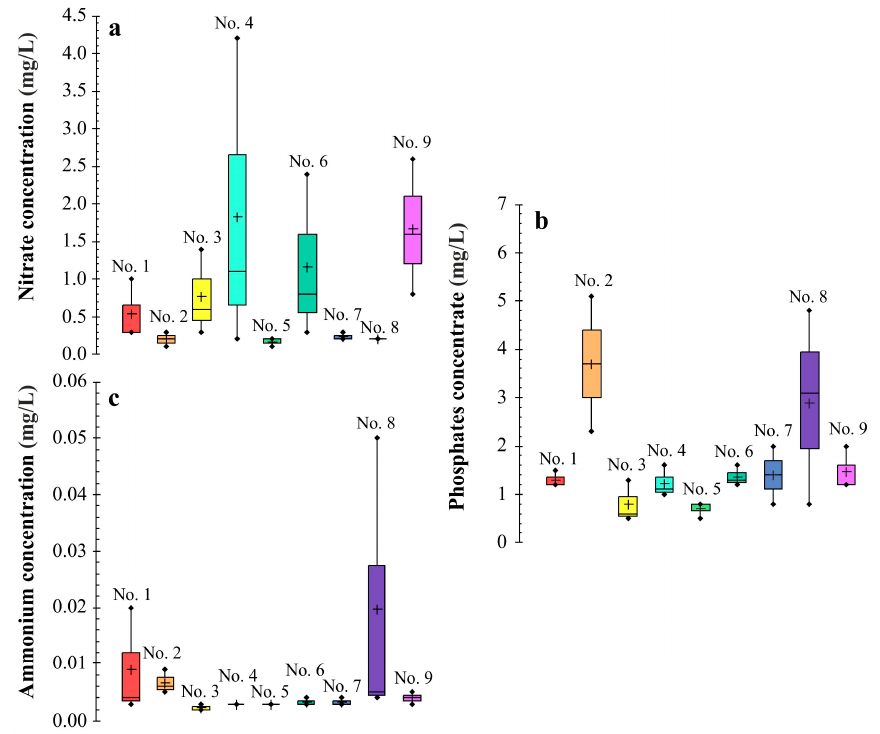
Figure 5. Boxplots showing the median, quartiles, and minimum and maximum values of quality parameters in the samples: ( a ) nitrate concentration; ( b ) phosphate concentration; ( c ) ammonium concentration.